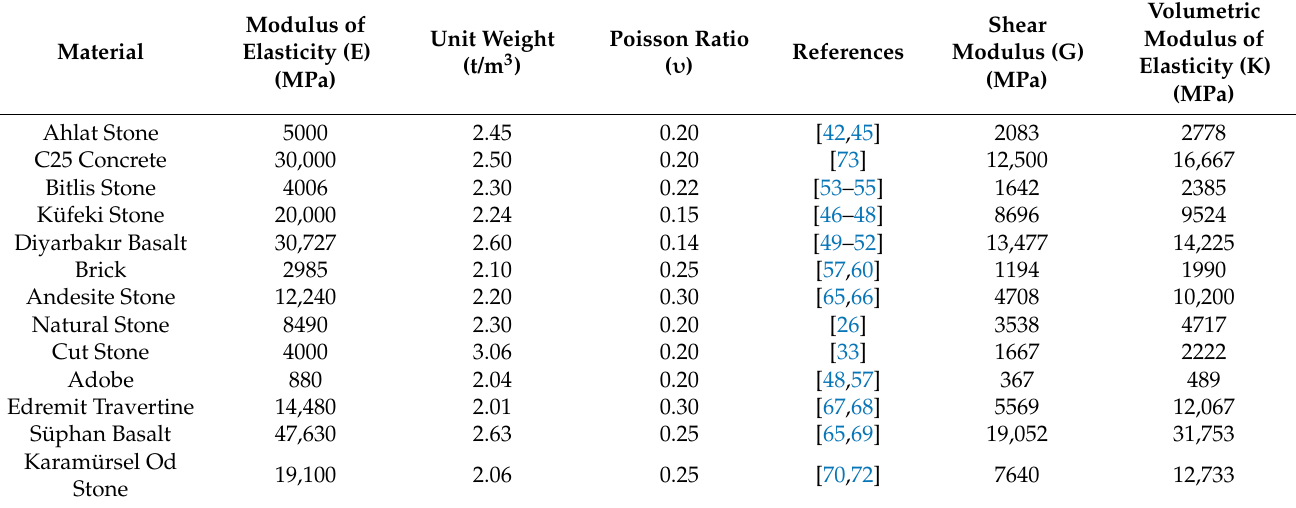
Table 1. Characteristics of selected material